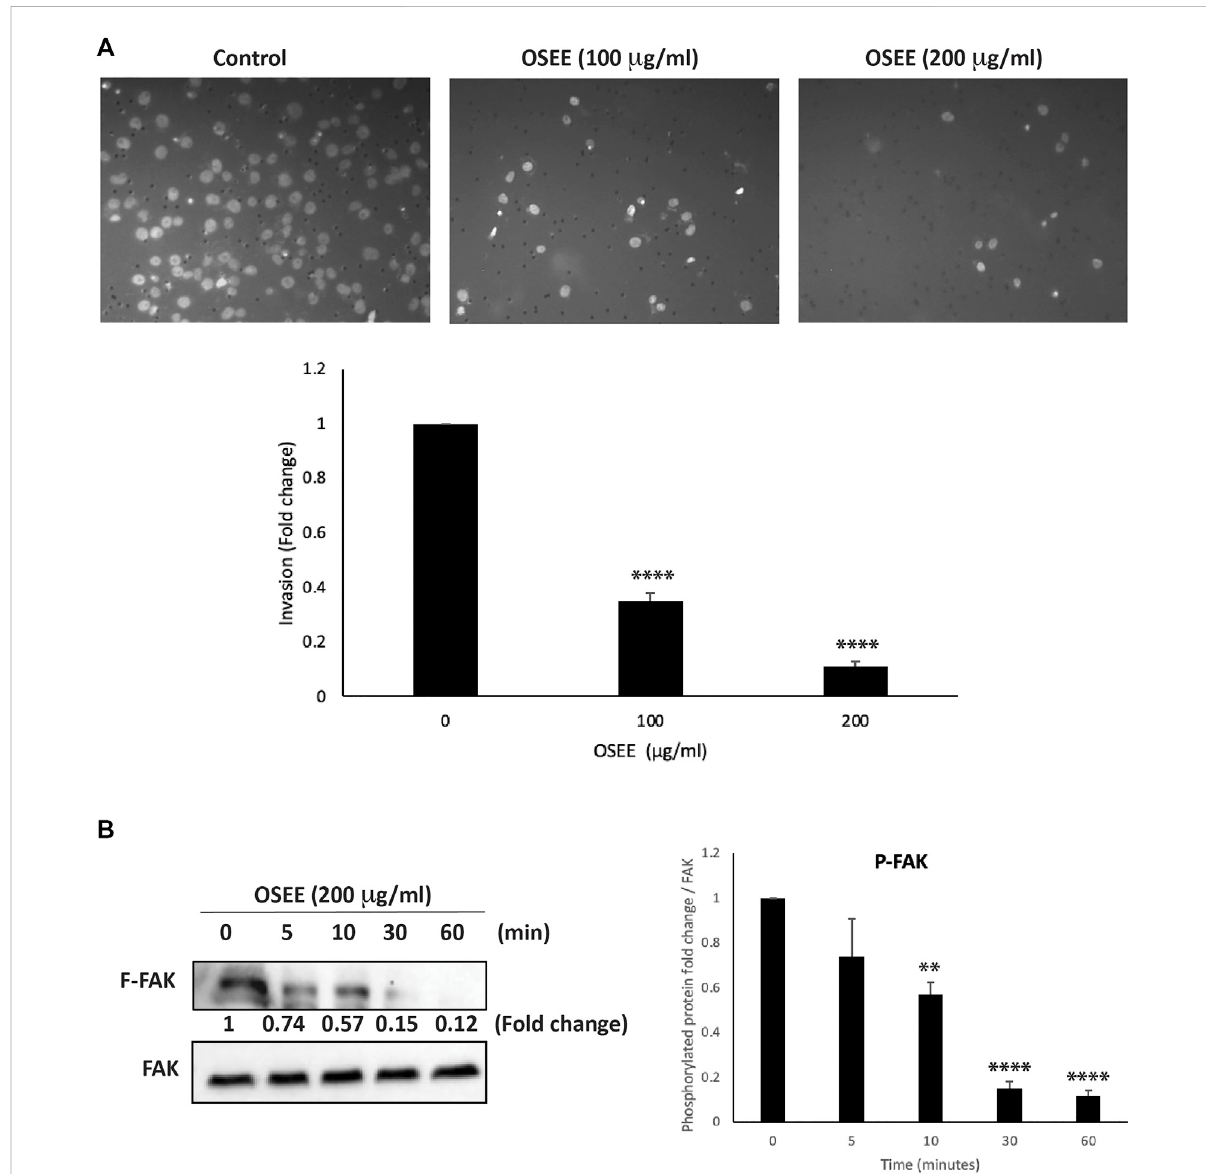
FIGURE 9 O. syriacum reduces the invasive potential of MDA-MB-231 cells. (A) MDA-MB-231 cells were incubated overnight with and without the indicated concentrations of OSEE inBoyden chamber trans-well inserts pre-coated with Matrigel as described in Materials and Methods. Cells that invaded the Matrigel were stained with DAPI, imaged, and then counted and analyzed. Values represent the fold change in migration of the ethanol- treated control. The experiment was repeated three times ( n = 3) and data represent the mean ± SEM (** p < 0.005, **** p < 0.0001). (B) Cells were treated with and without 200 μ g/ml OSEE at different time points and the phosphorylation of FAK was assessed at hose points by Western blotting,usingtotal-FAKasloadingcontrol.TheWesternblotisrepresentativeofthreeindependentexperiments( n =3).** p < 0.005,**** p <